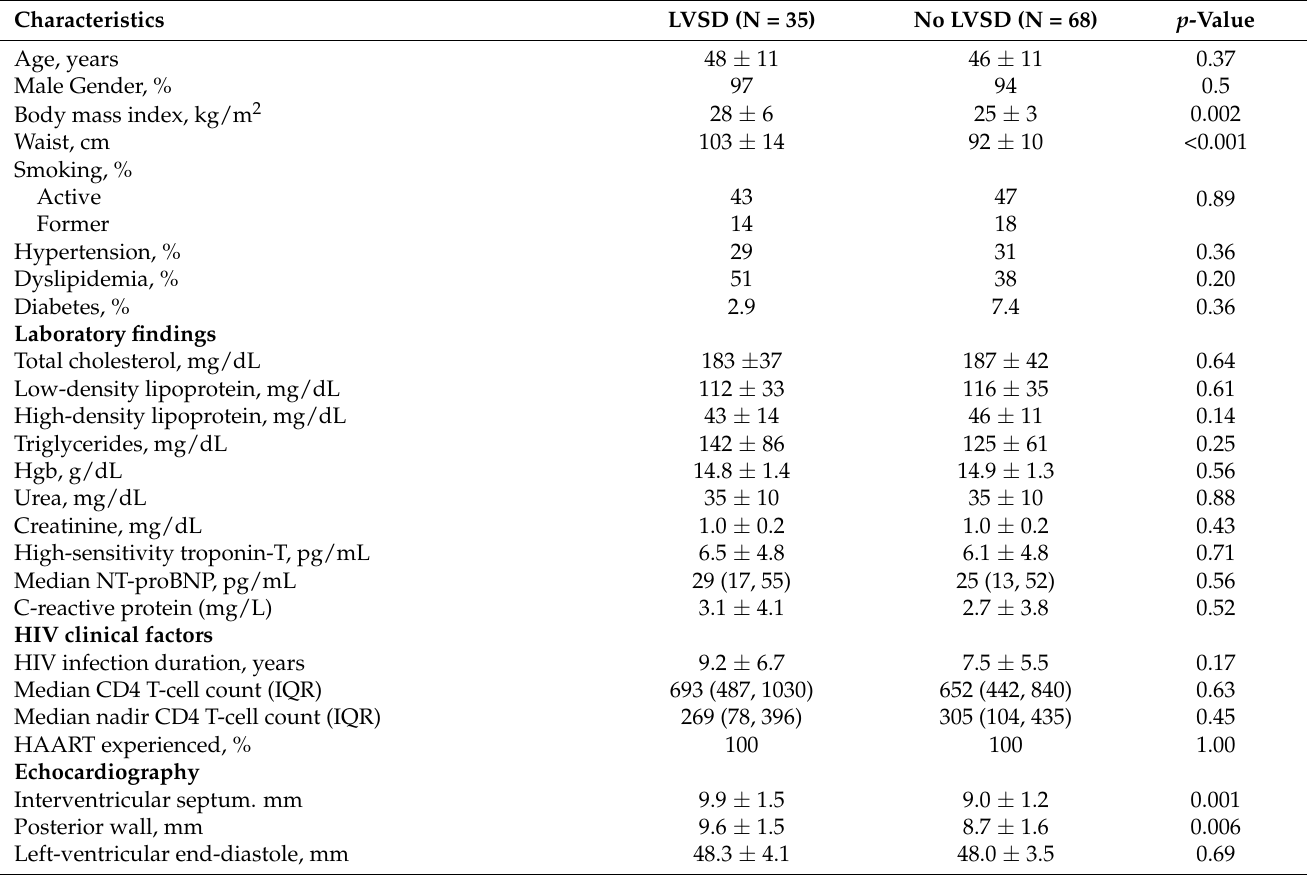
Table 3. Characteristics of PLWH with and without early left ventricular systolic